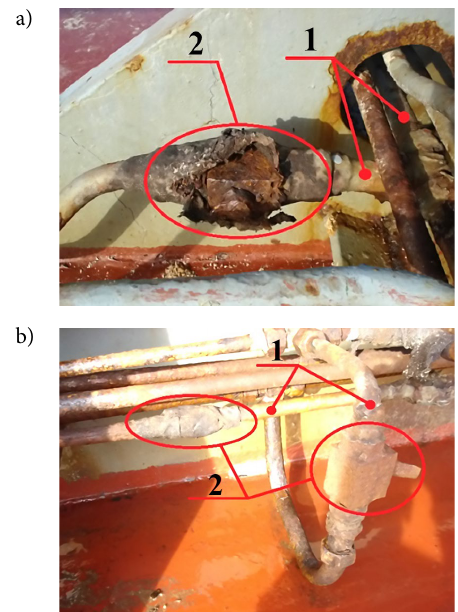
Figure 8. Types of damage hydraulic system for open/ close the cover for cargo holds on a container ship SEASPAN